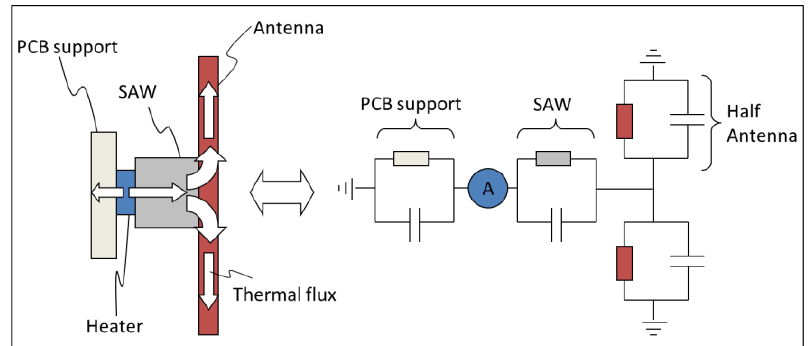
Figure 7. Thermal-Electrical conversion.